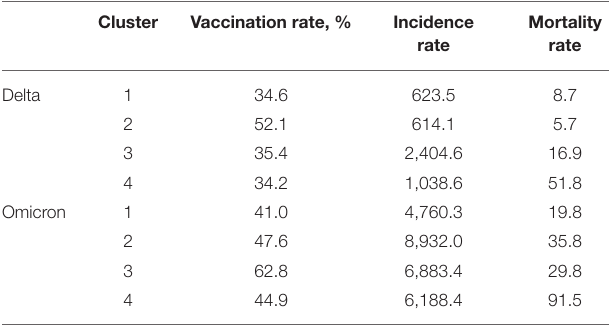
TABLE 1 | K-means clustering estimations for the Delta (July 1, 2021 to August 31, 2021) and Omicron (December 1, 2021 to January 31, 2022) waves in the US.